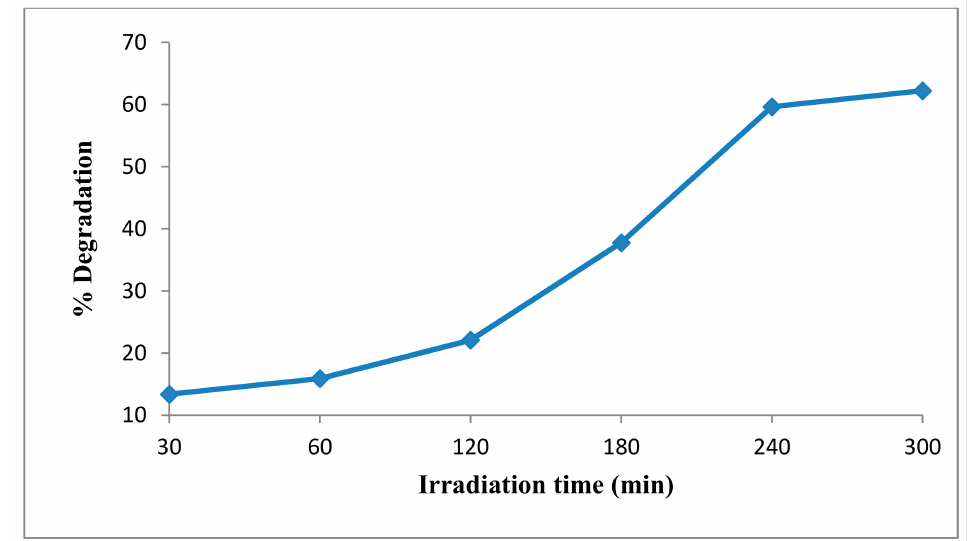
Figure 7. Time profile study for % degradation of RB catalyzed by Pd/ZrO 2 .